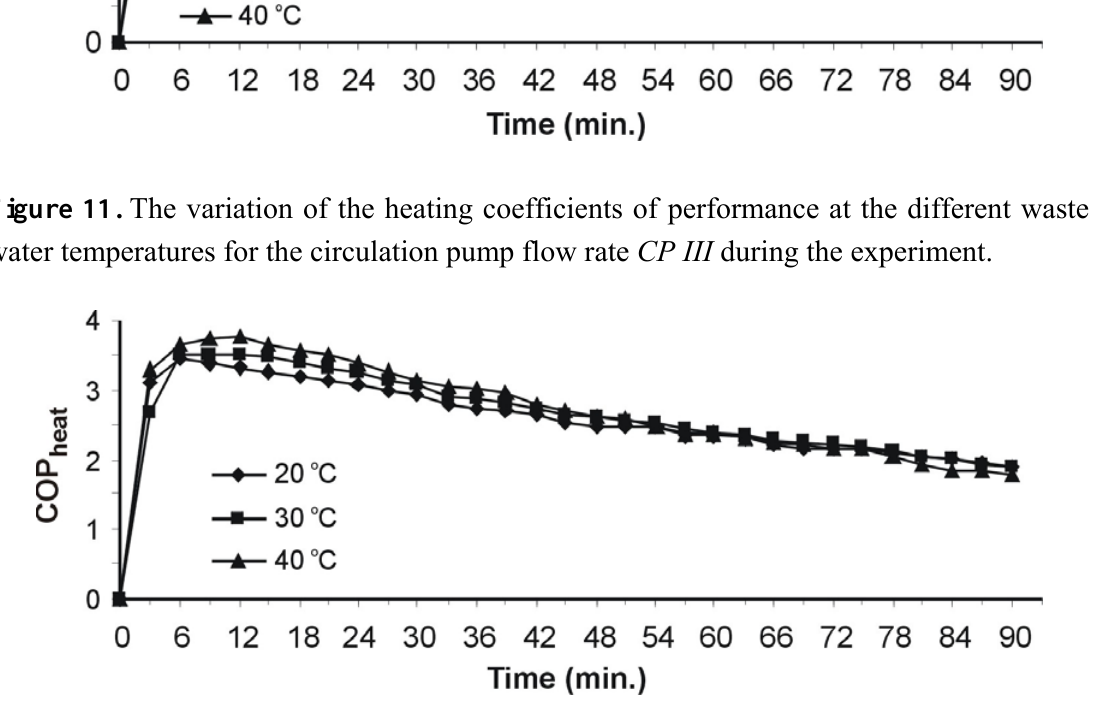
Figure 12. The variation of time averaged heating coefficients of performance according to the circulation pump flow